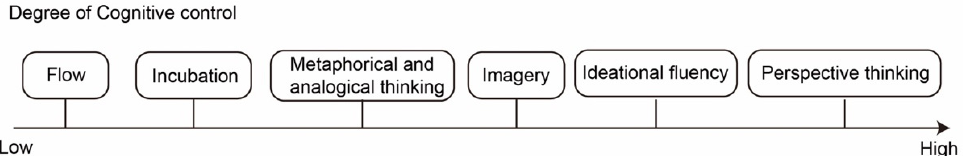
Figure 1. Schematic illustrating the basis for the Cognitive Processes Associated with Creativity (CPAC) scale.